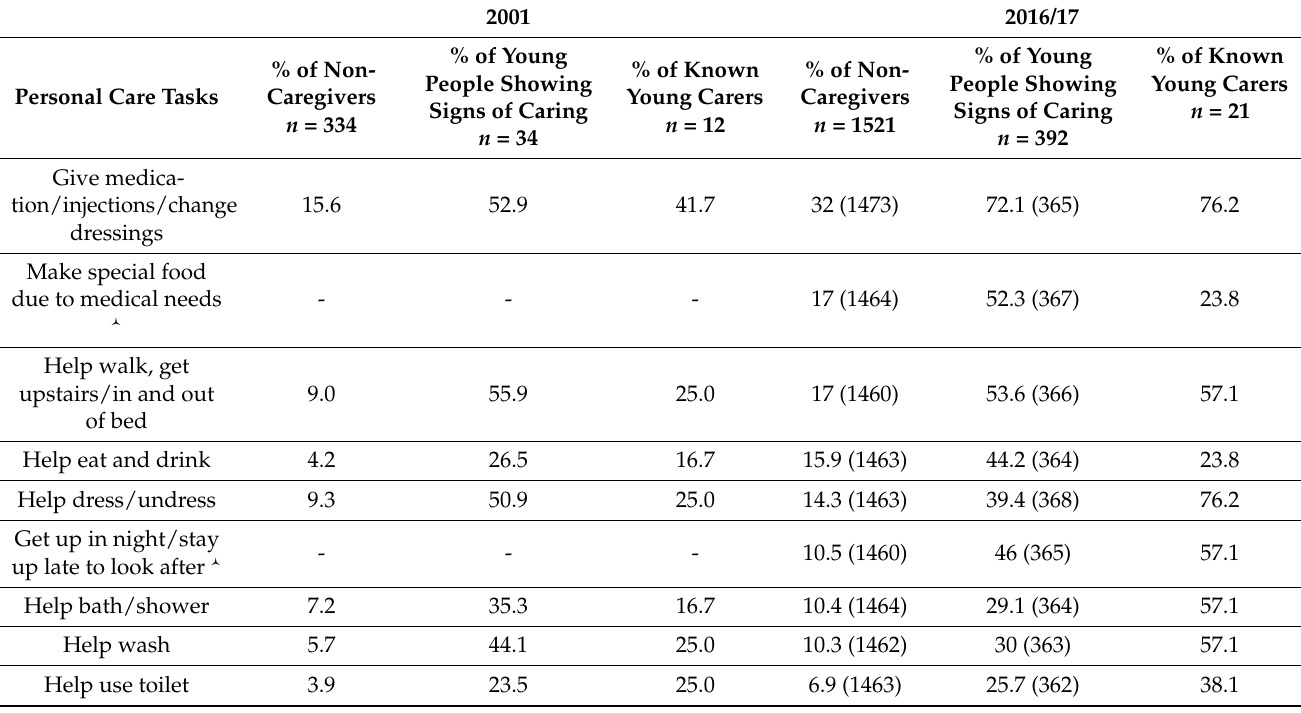
Table 5. Nature of personal care tasks undertaken by non-caregivers, young people showing signs of Table 3. Nature of general and other care tasks undertaken by non-caregivers, young people show- caring and known young carers in 2001 and 2016/17. ing signs of caring and known young carers in 2001 and 2016/17.